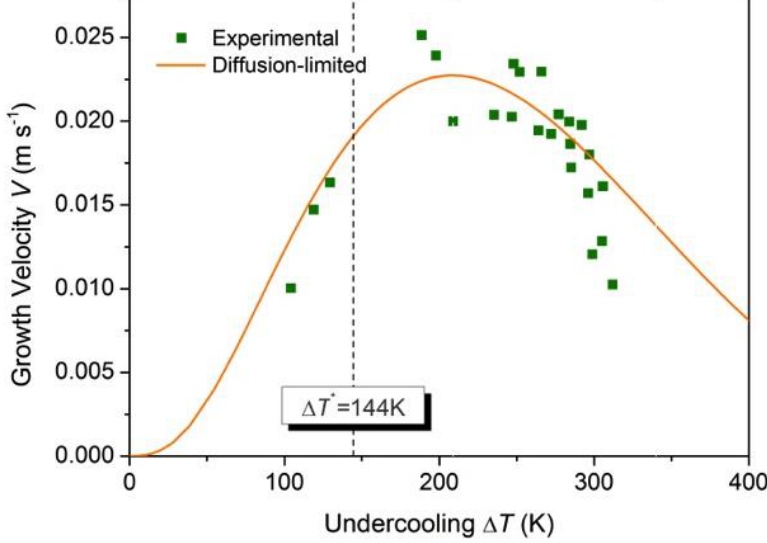
Figure 14. Measured growth velocity V as a function of undercooling ∆T (squares ) . There is a specific undercooling: At ∆T* = 144 K the thermal undercooling ∆T kinetic undercooling ∆T , The solid line gives the prediction of dendrite growth theory k assuming diffusion-limited growth and taking into account a temperature dependent diffusion coefficient (see the